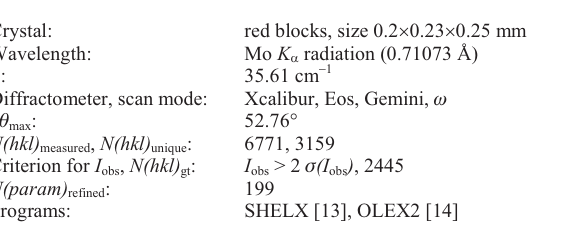
Table 1. Data collection and handling.